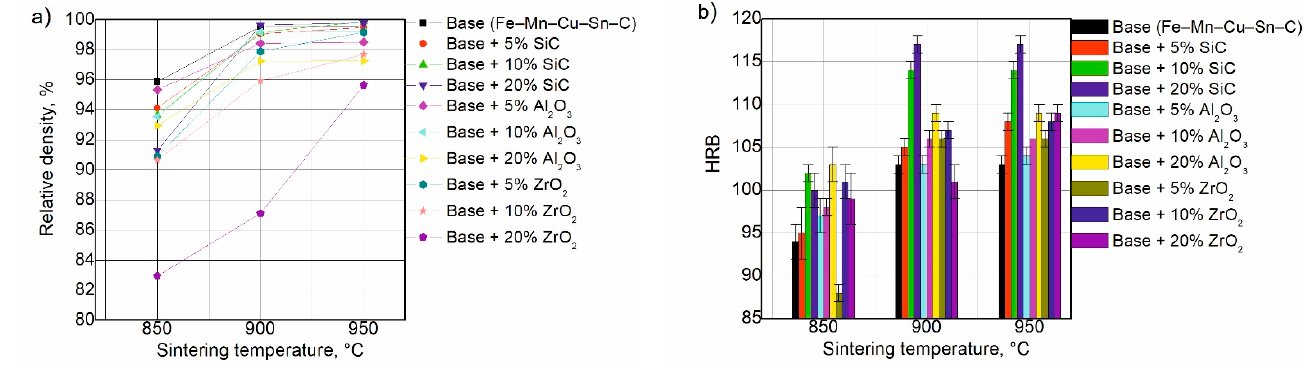
Figure 4. Relative density ( a ) and HRB ( b ) of iron-based matrix composites sintered by SPS.